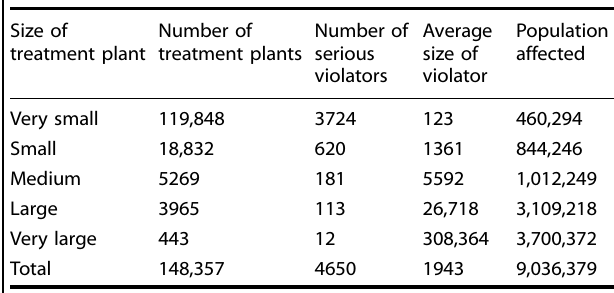
Table 1. Size of public water system by population served 30 . Table 2. Serious violators in 2019 30